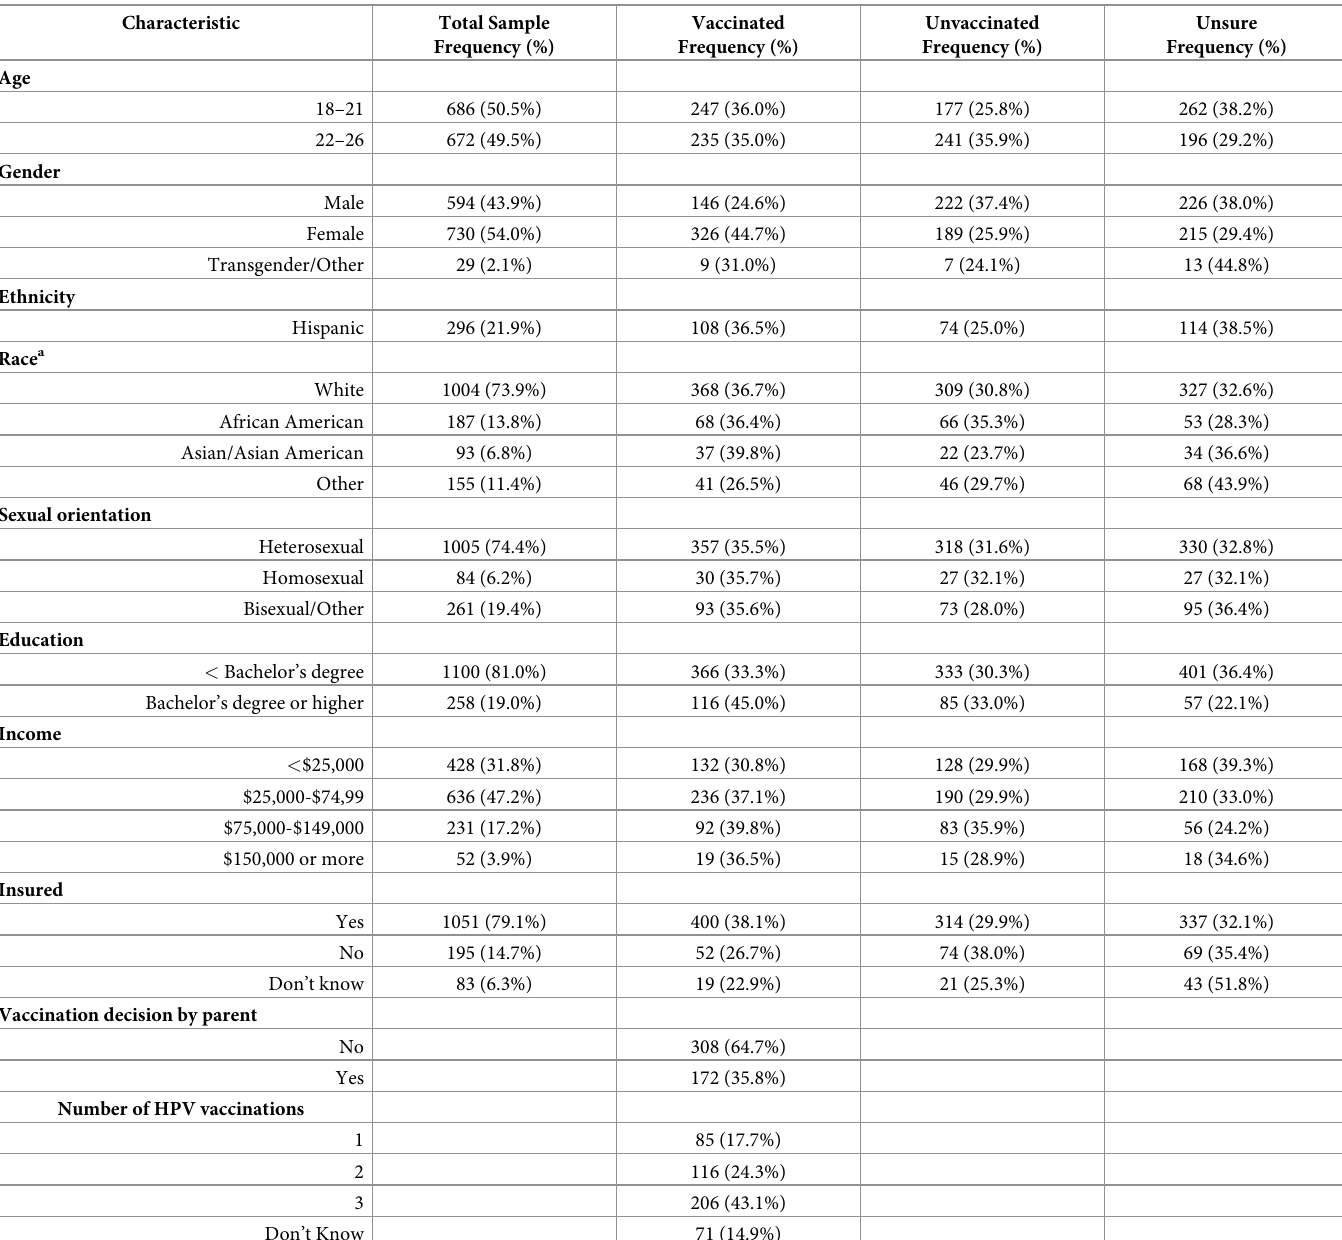
Table 2. Respondent